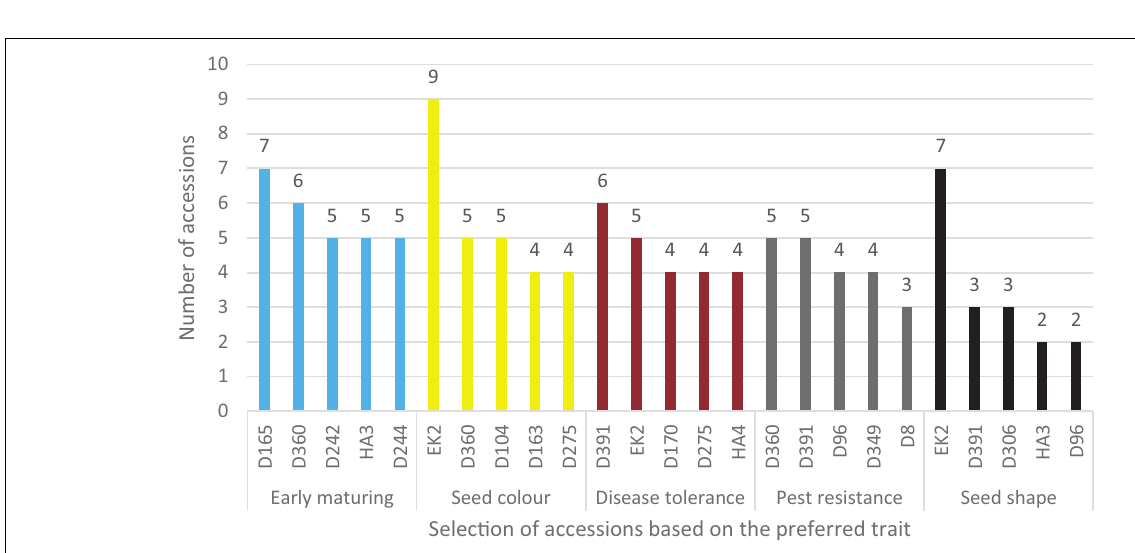
FIGURE 13 | Selection of five accessions based on their uses.